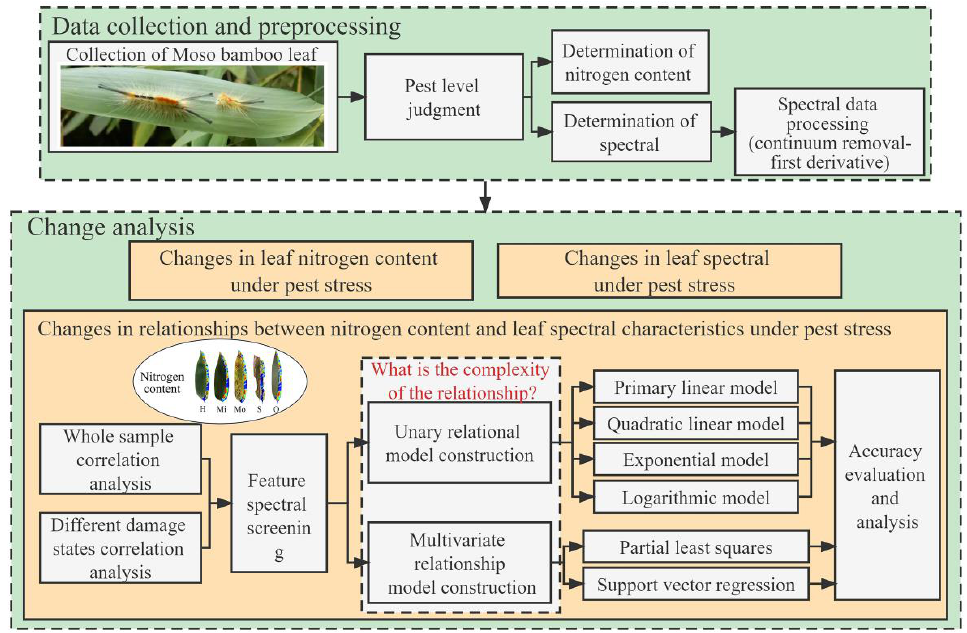
Figure 3. Workflow of changes in the relationship between nitrogen content and leaf spectral characteristics under PPC stress.